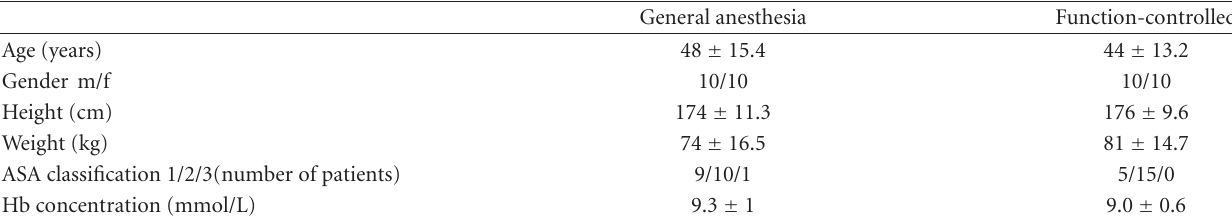
Table 1: Patient demographics.